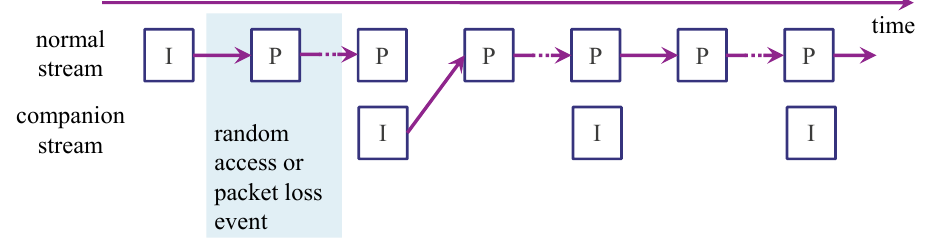
Figure 2. After a random access or packet loss event, a companion stream keyframe replaces the collocated predicted